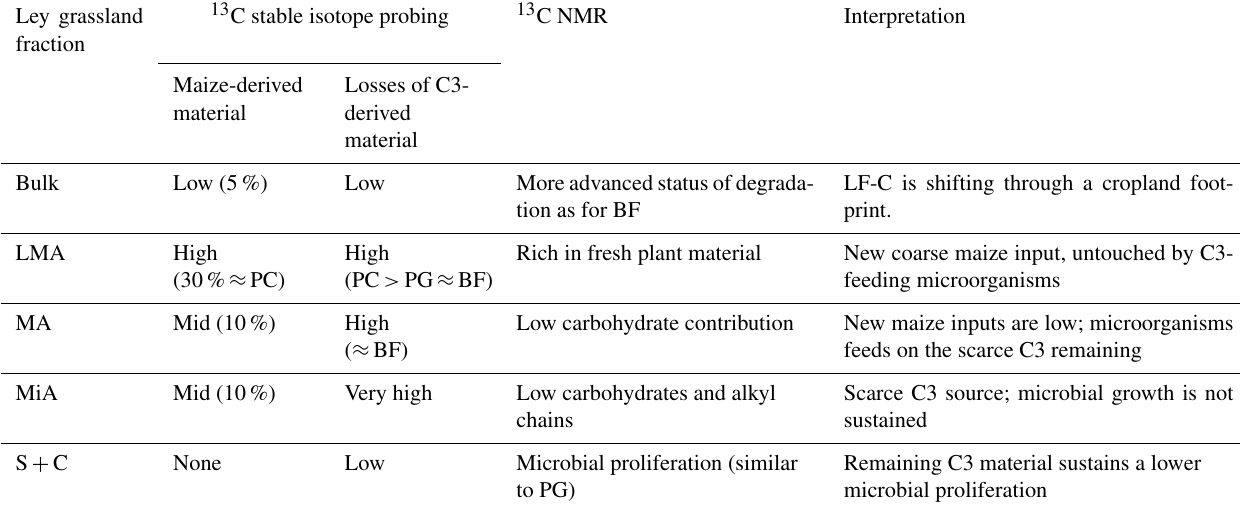
Table 4. Summary of the characteristics of light fraction C isolated from bulk soil and aggregates of ley grassland. A decoupling between SOM dynamics within larger aggregates and fine fractions is